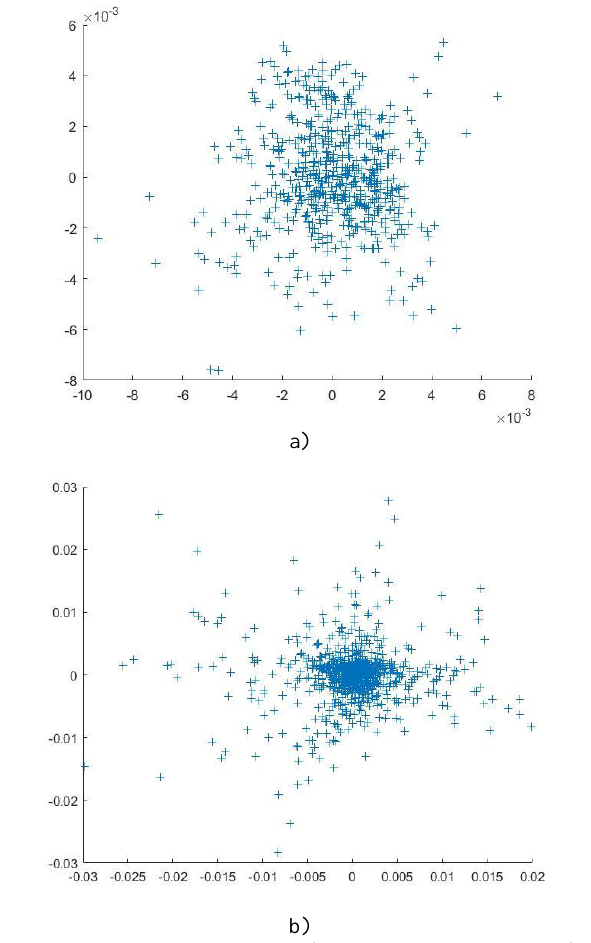
Figure 6. Re-projection errors. a) for conventional method, b)